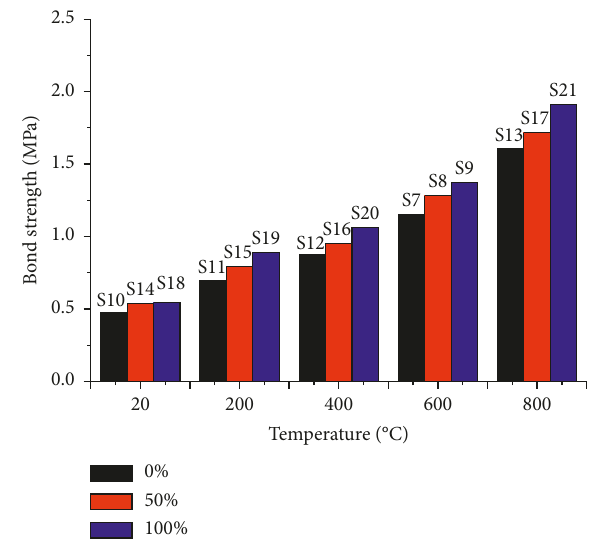
Figure 5: Effect of temperature on bond